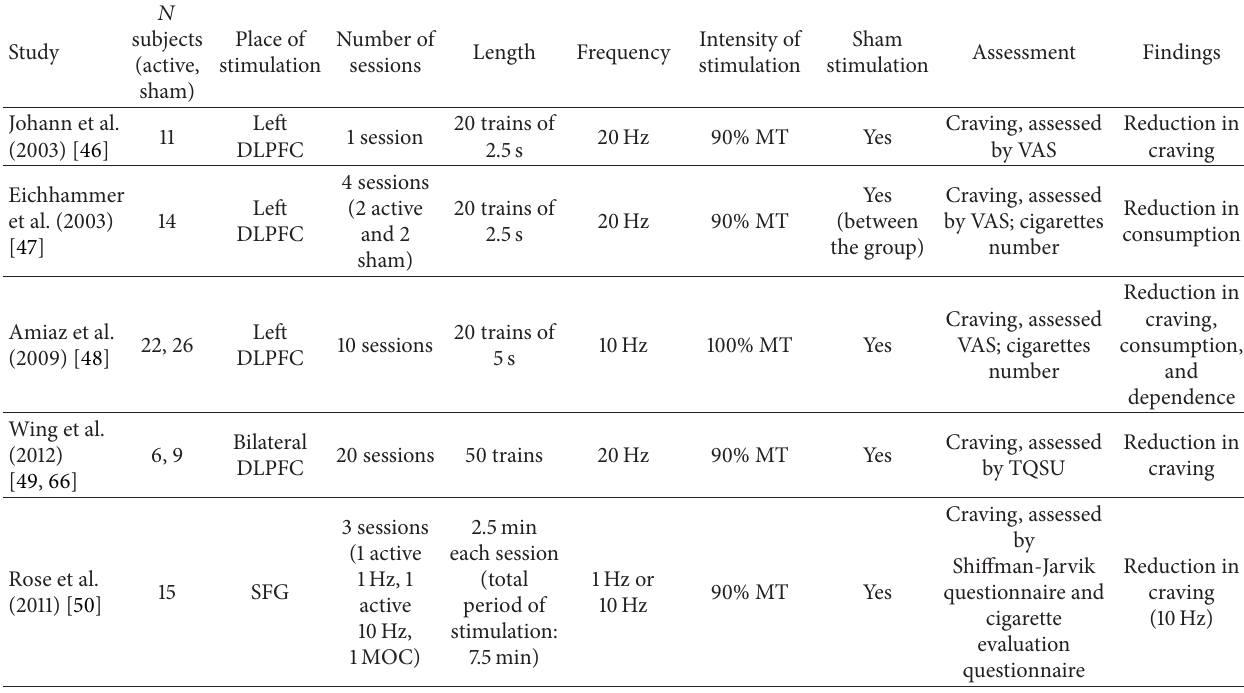
Table 1: Summary of the studies on rTMS in the treatment of nicotine